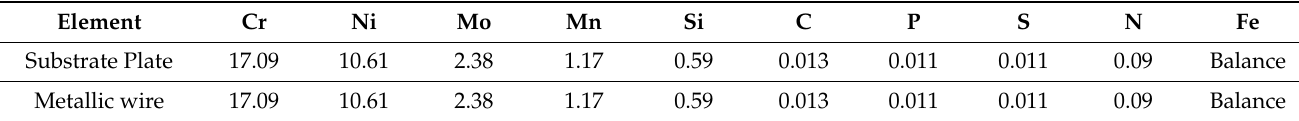
Figure 1. Experimental setup of WAAM process. Table 1. Chemical composition substrate and metallic wire (SS 316L) [8].